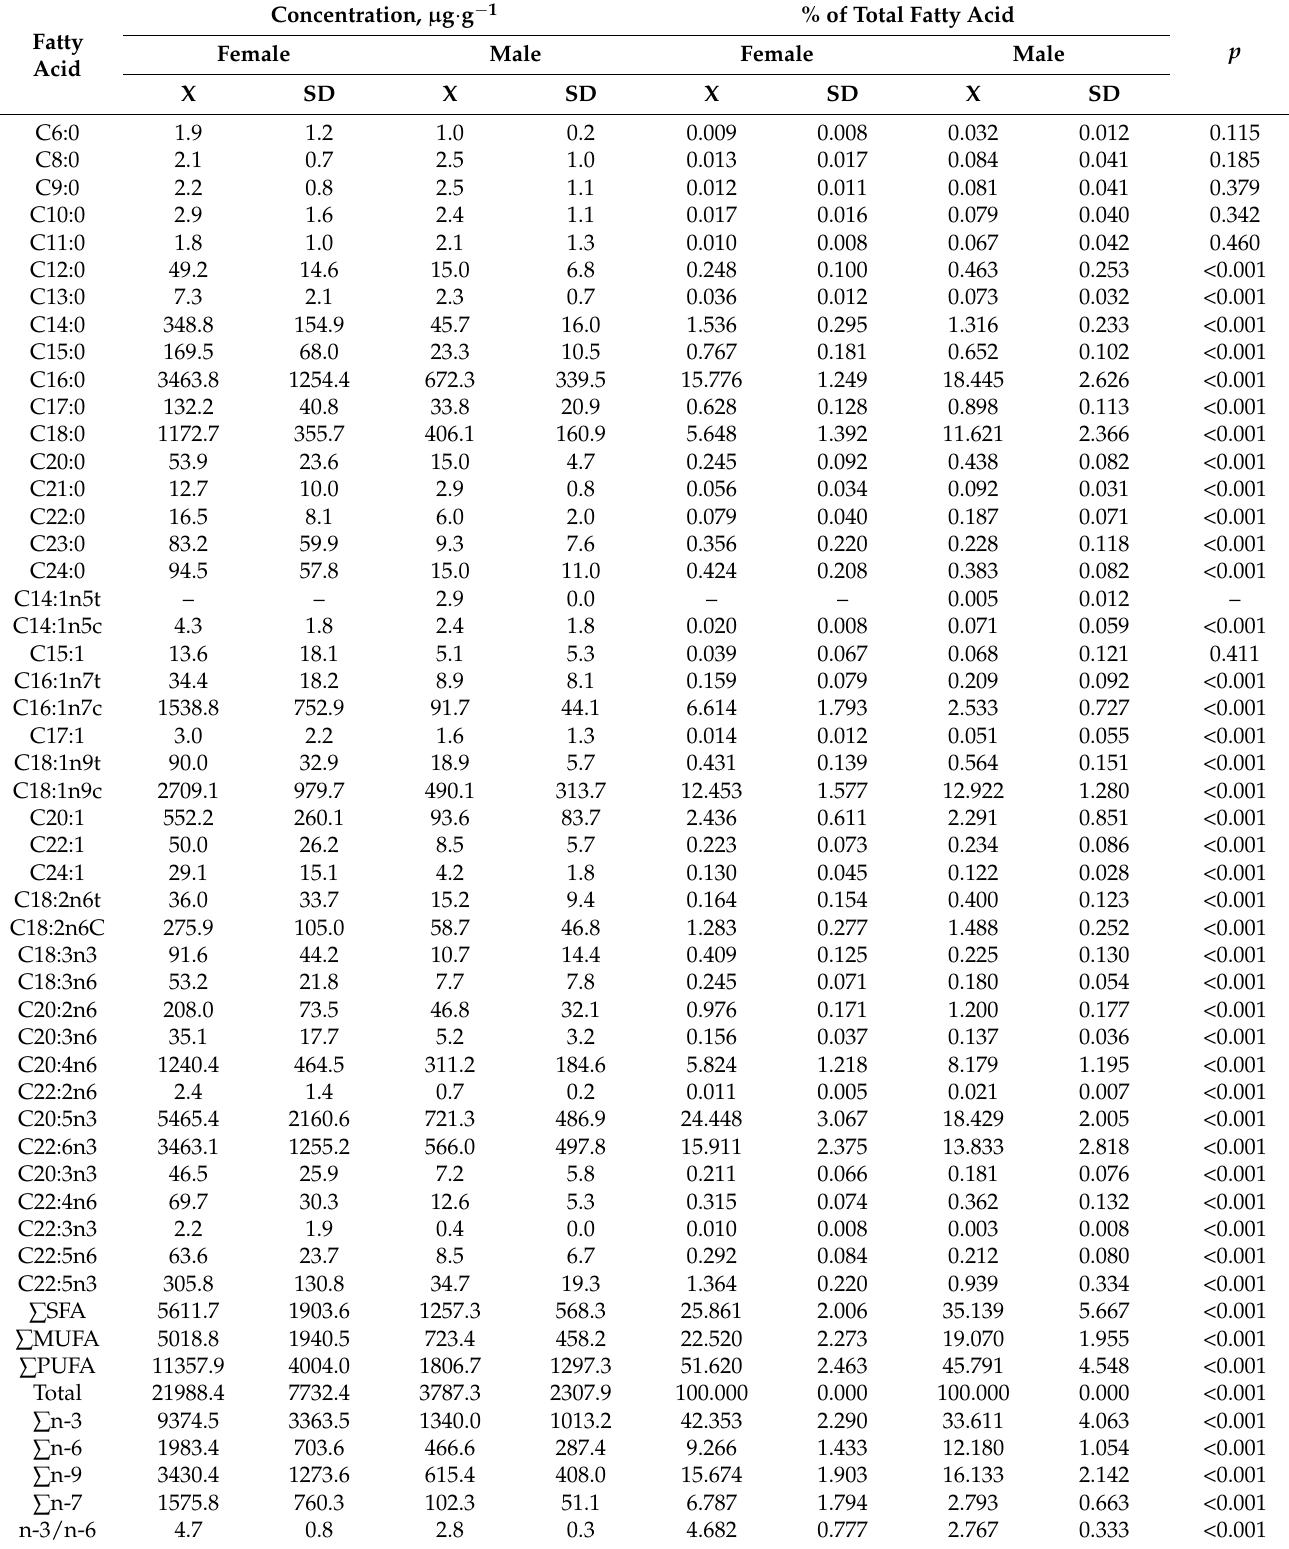
Table 2. Fatty acid composition in the gonads of red king crabs from Dalnezelenetskaya Bay, Barents Sea,